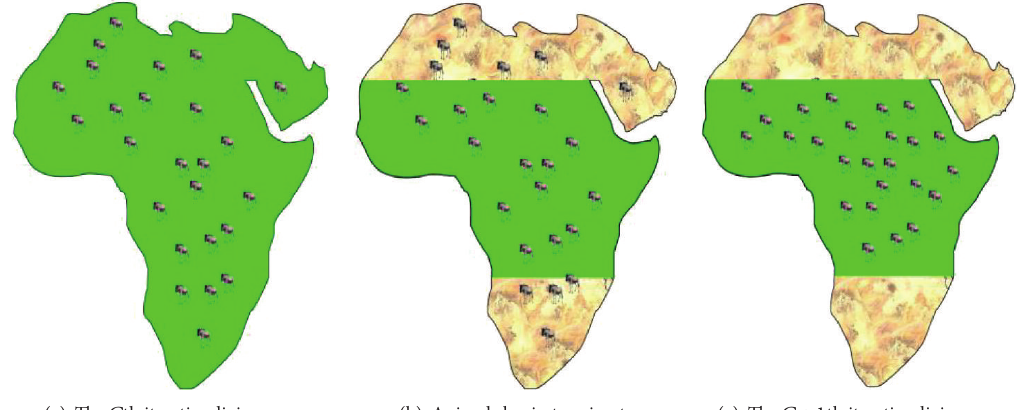
Figure 2: Animals migration process.